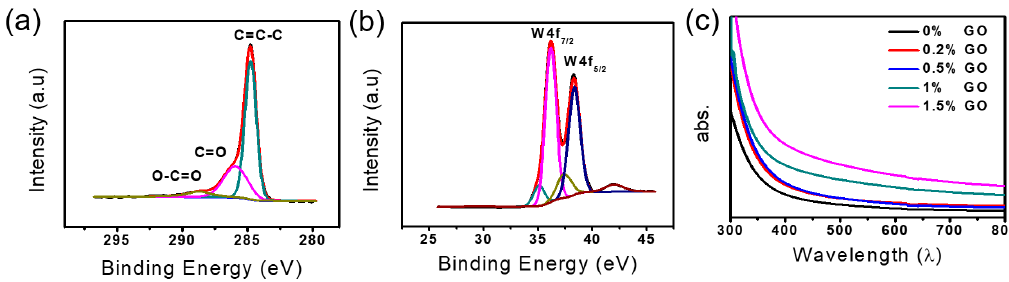
Figure 3. ( a ) XPS spectra of 0.5 wt. % W 18 O 49 NWs/rGO composite, ( b ) W4f core-level spectra of 0.5 wt. % W 18 O 49 NWs/rGO composite, ( c ) UV–vis spectra of W 18 O 49 NW and W 18 O 49 NWs/rGO composites (0.2, 0.5, 1, and 1.5 wt. %).